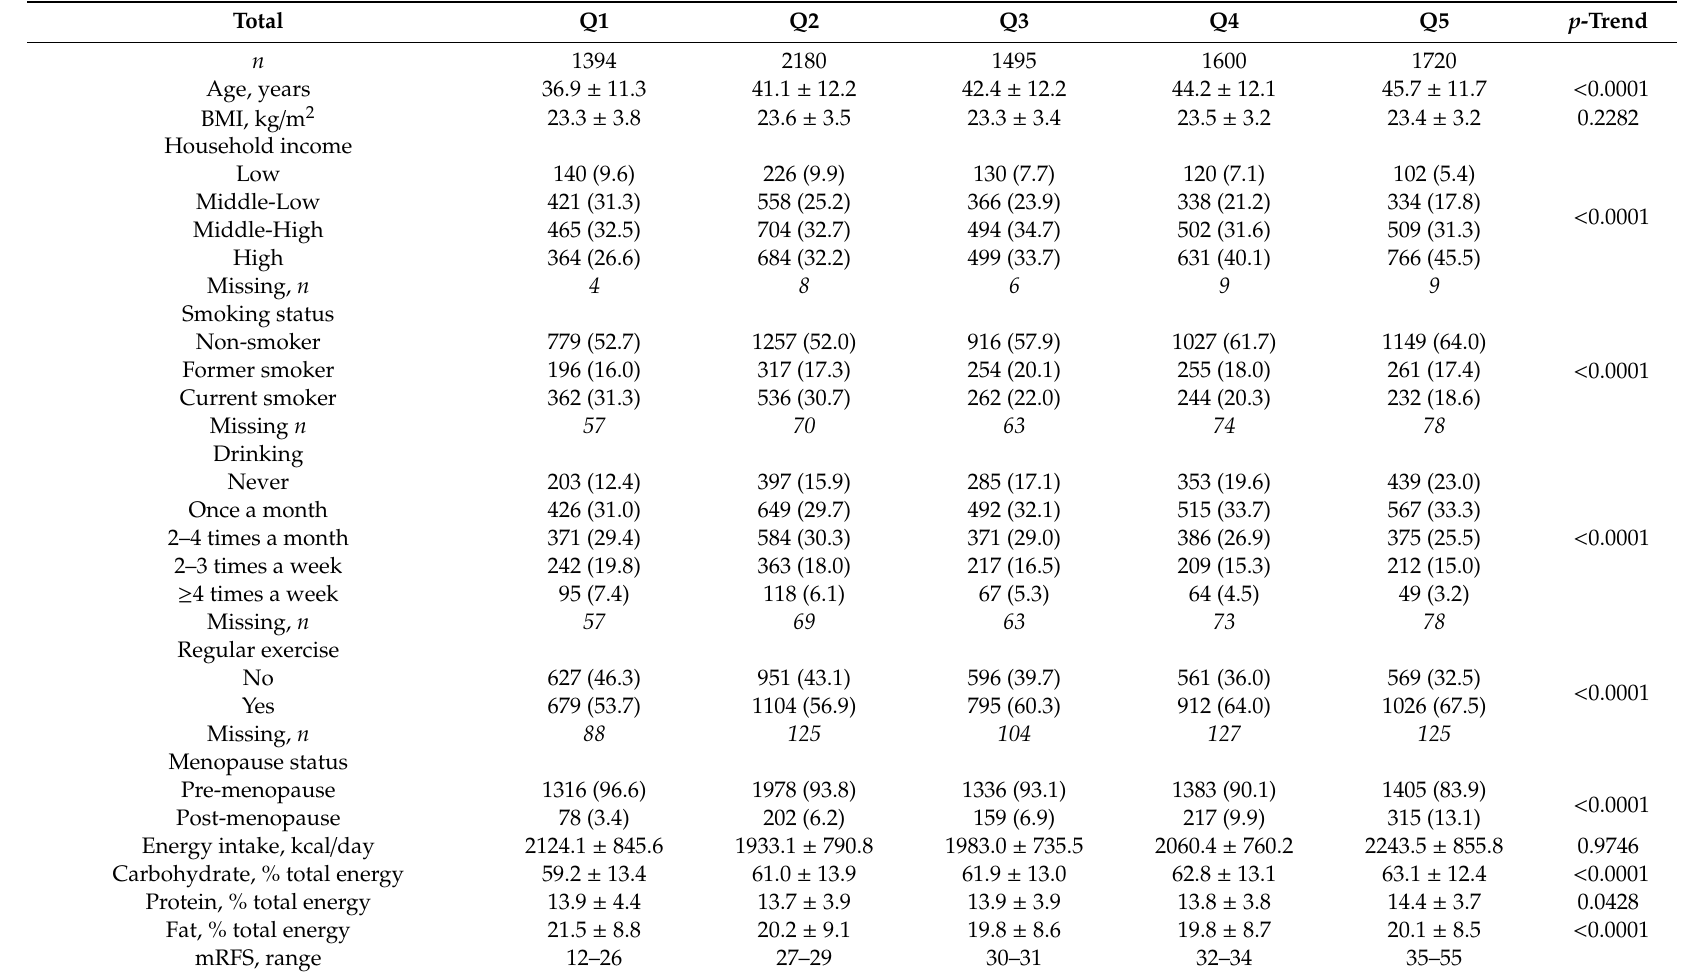
Table 2. General characteristics of the participants by quintile (Q1–Q5) of the